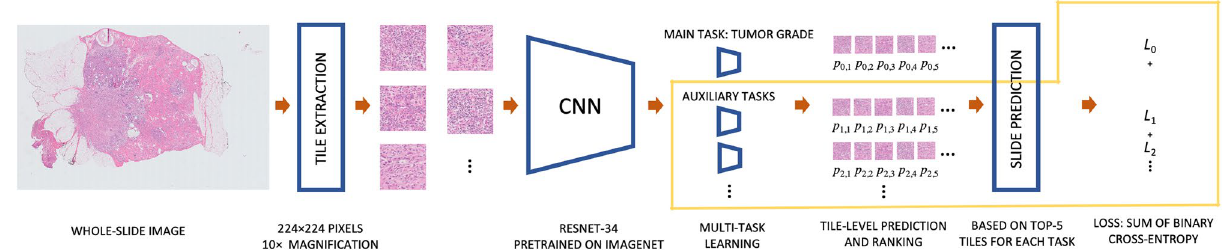
Figure 1. Overview of the deep learning model and training procedure. The components of the model outlined in yellow are used only at training time, this includes the multi-task learning with the auxiliary tasks and the computation of the loss